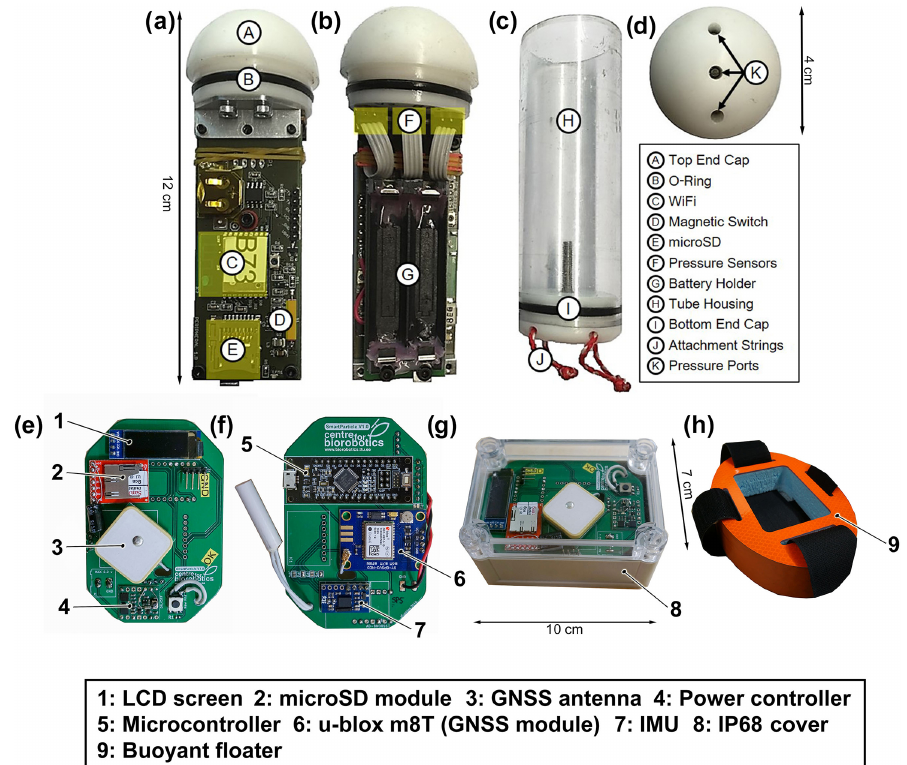
Figure 1. Two different drifter platforms have been used in this study: a submersible drifter (a–d) and a GNSS surface drifter (e–h) . (a) Side view showing the submersible-drifter electronics. (b) Side view showing the reverse side of the electronics board including the battery holder and pressure sensors. (c) Polycarbonate tube housing of the submersible drifters with attachment strings for balloons used for manual buoyancy adjustment. (d) Top view facing the cap, showing the ports for each of the three pressure sensors. (e) Side view showing the GNSS surface drifter electronics with an LCD screen, microSD storage, a GNSS antenna and a power controller. (f) Side view showing the reverse side of the GNSS surface drifter electronics with a microcontroller, GNSS receiver and IMU. (g) The electronics of the GNSS surface drifter are sealed in a waterproof box. (h) The box gets placed at the center of a 20cm long